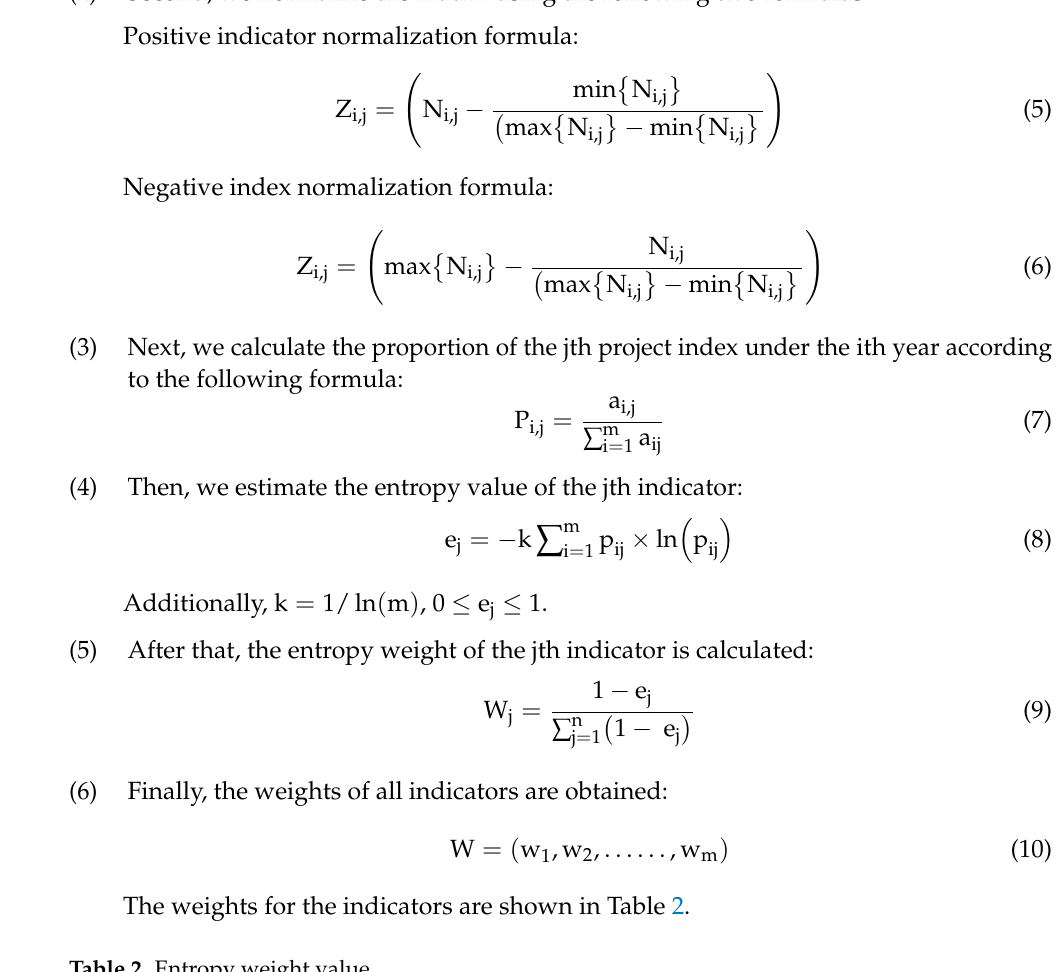
Table 2. Entropy weight